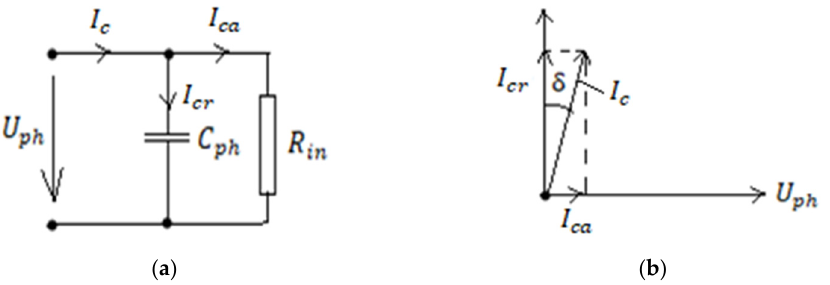
Figure 2. Equivalent scheme of the capacitance of the phase conductor to ground ( a ). The phasor diagram associated with the diagram in Figure 2a ( b ).